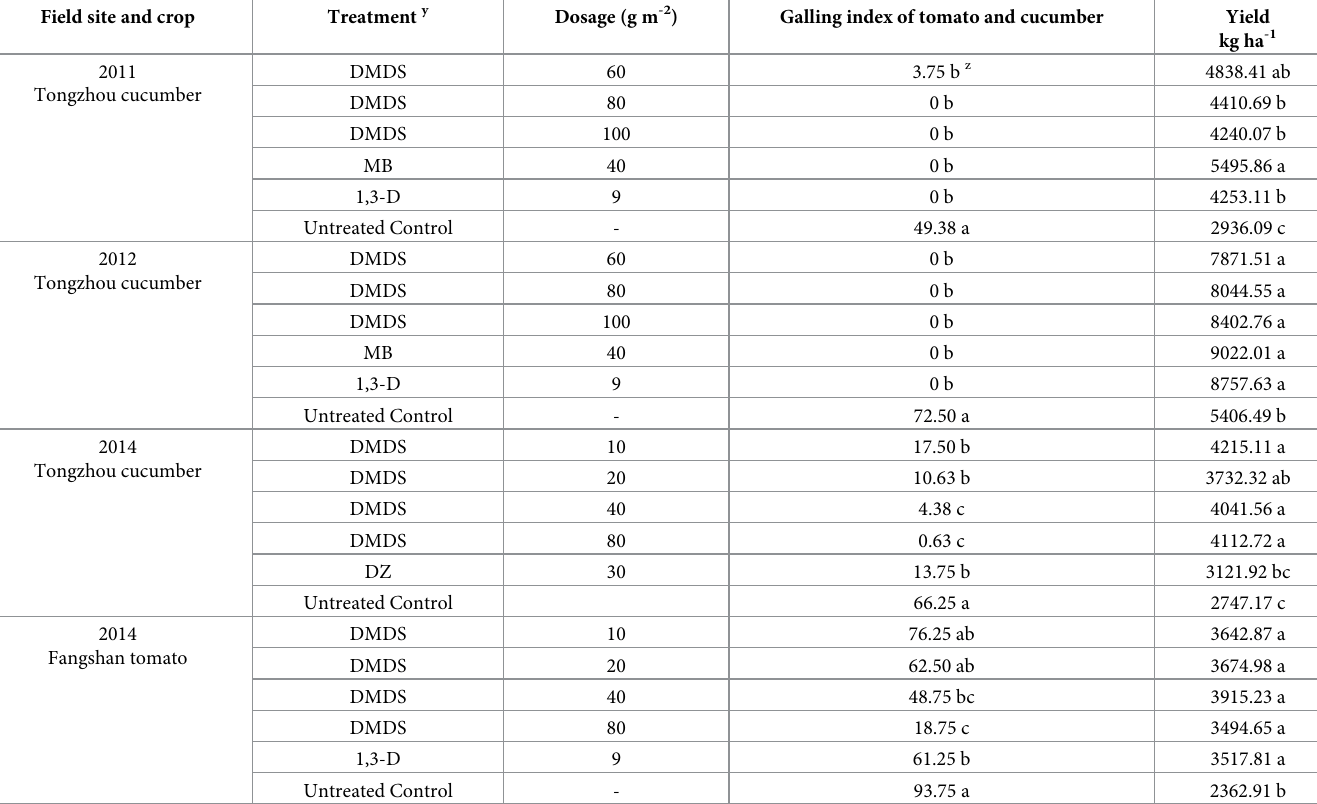
Table 5. Marketable yield of crop and galling index at